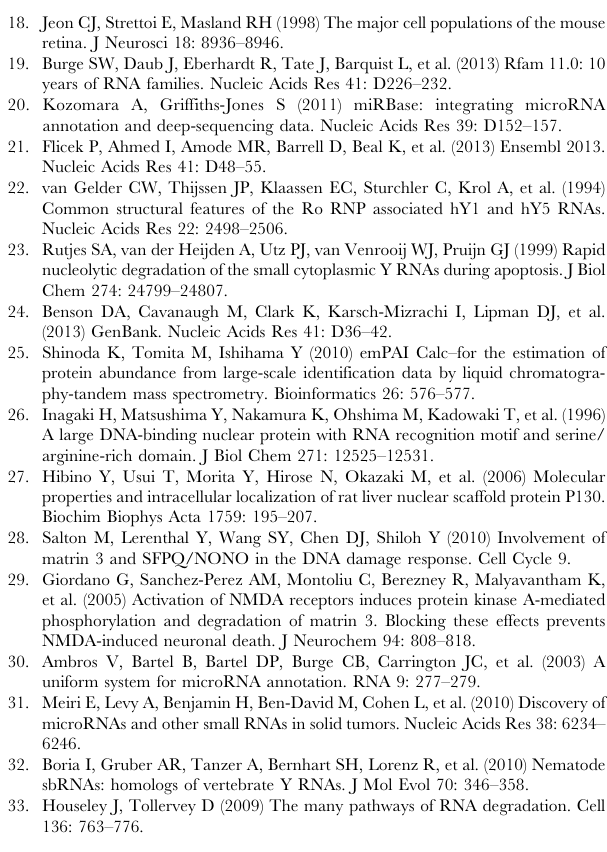
Figure S2: Specificity of pY RNA1-s2 probe used for In-situ hybridization. Figure S3: Identification of Matr3 by mass spectrometry. Figure S4: Matrin 3 cytoplasmic and nuclear localization. Figure S5: Alignment of the RRM domains